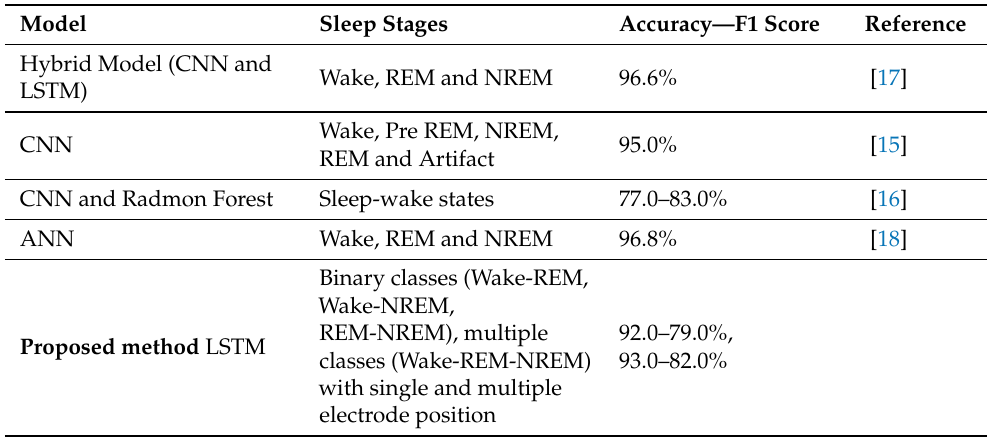
Table 10. Performance comparison with existing state-of-the-art methods